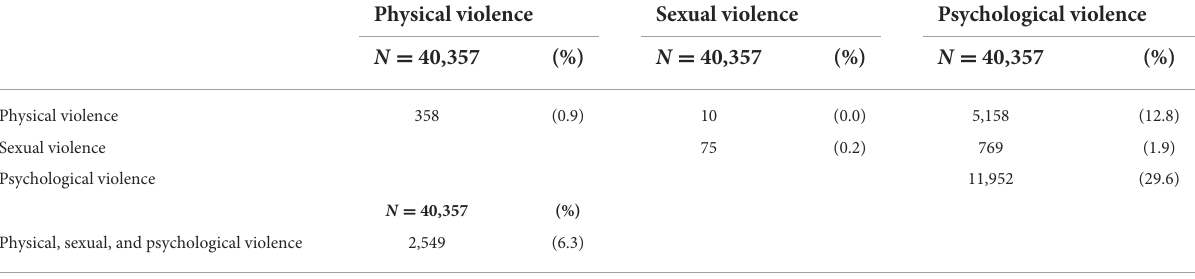
TABLE 4 Lifetime prevalence of all combinations of reported types of intimate partner violence (psychological, physical, and sexual) in ever-partnered women ( n =